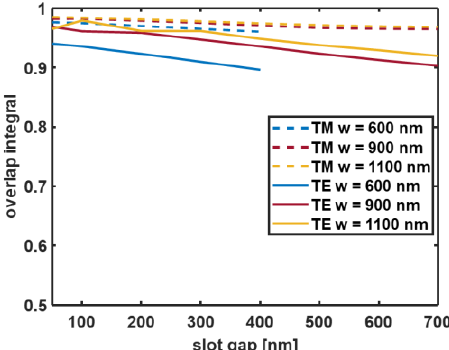
Figure 2. Overlap integral calculated according to Equation (3) as a function of the initial slot gap value g. The blue, red, and yellow curves correspond to configurations A (w = 600 nm), B (w = 900 nm), and C (w = 1100 nm), respectively. For each value of the slot gap g, the slot rail width s can be calculated from the formula s = (w − g) / 2. The wavelength is λ = 1.55